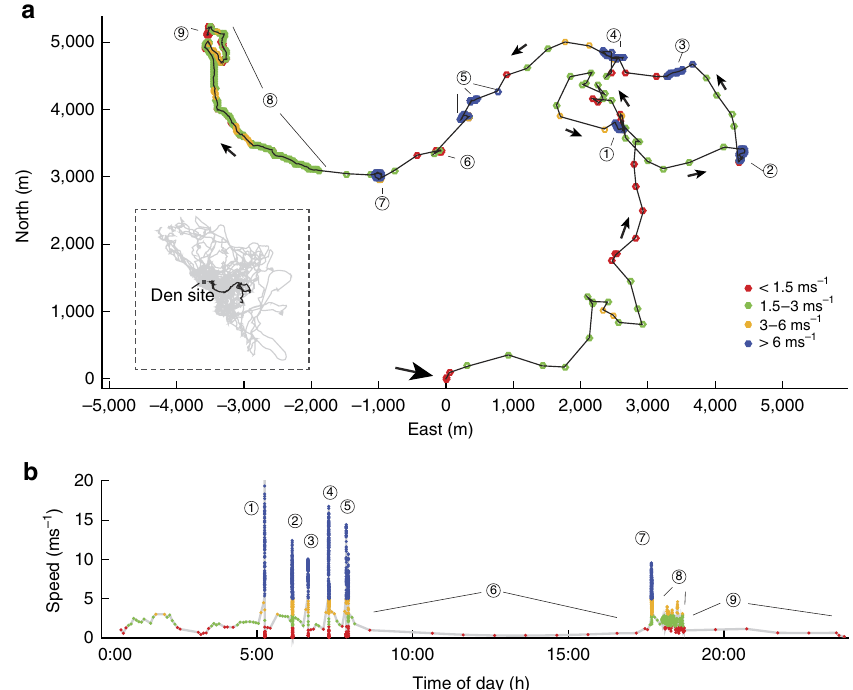
Figure 1 | Example day’s speed and track for an African wild dog. ( a ) GPS data trace for one individual, dog position at the beginning of the day (0/0), GPS position colour coded based on speed bins, black arrow shows the direction of the movement, inset shows range covered by dogs during 5 months of observation and trace of example day. ( b ) Speed profile at local time for one individual colour coded based on speed bins (legend in a ). ( a , b ) Movement is interspersed by six fast chases (circles 1–5 and 7). The GPS sample rate varies throughout the day and is set to capture high-resolution data when the animal is moving. When the animal is stationary, the sampling interval is once an hour (circles 6 and 9). Between 18:00 and 20:00, it is at 10-s intervals (when moving, circle 8), when high-speed chases are detected, it is increased to 5Hz (circles 1–5 and 7). At all other times, it is once every 5min when moving.